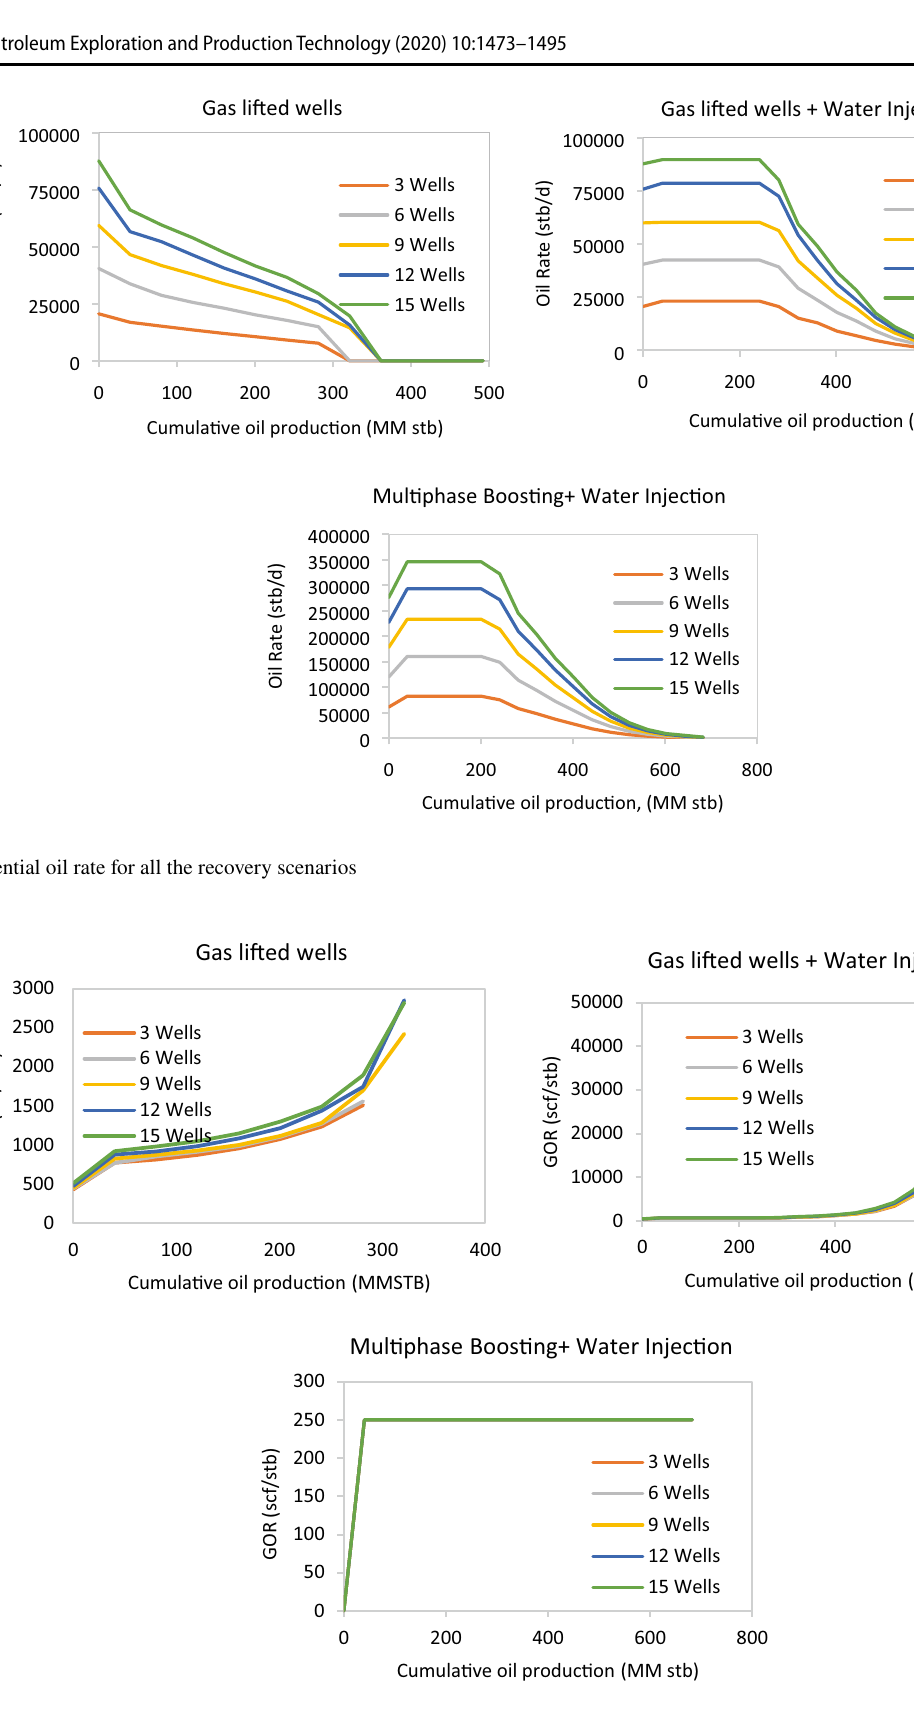
Fig. 15 Potential GOR for all recovery